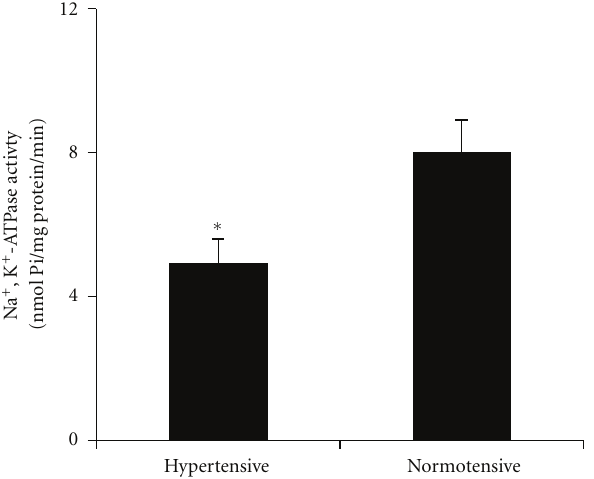
Figure 1: Na + ,K + -ATPase activity (nmol Pi/mg protein/min) in membrane of erythrocyte of hypertensive ( n = 8) versus normotensive ( n = 8) subjects. P < 0 . 05 by two-tailed unpaired Student’s t -test.